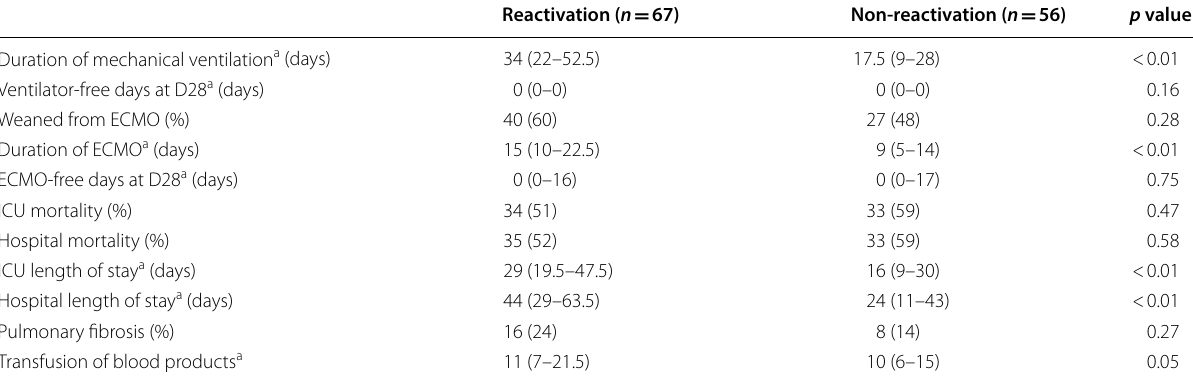
Data are presented as median and interquartile range or absolute value and percentage a Median, 1st–3rd